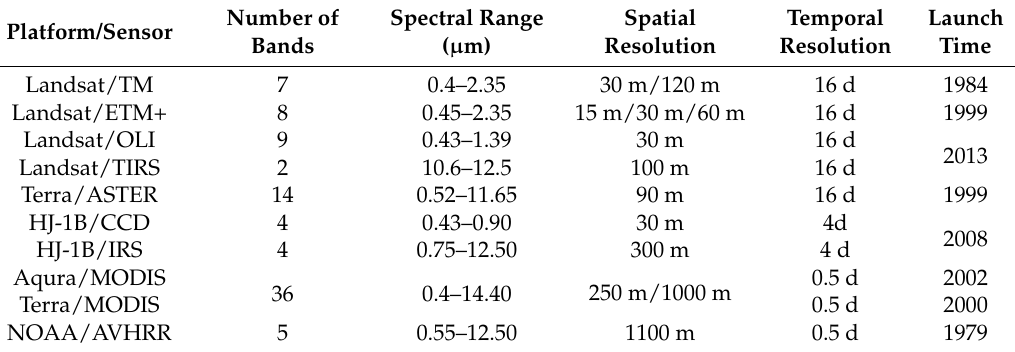
Table 2. The major multispectral data sources for drought